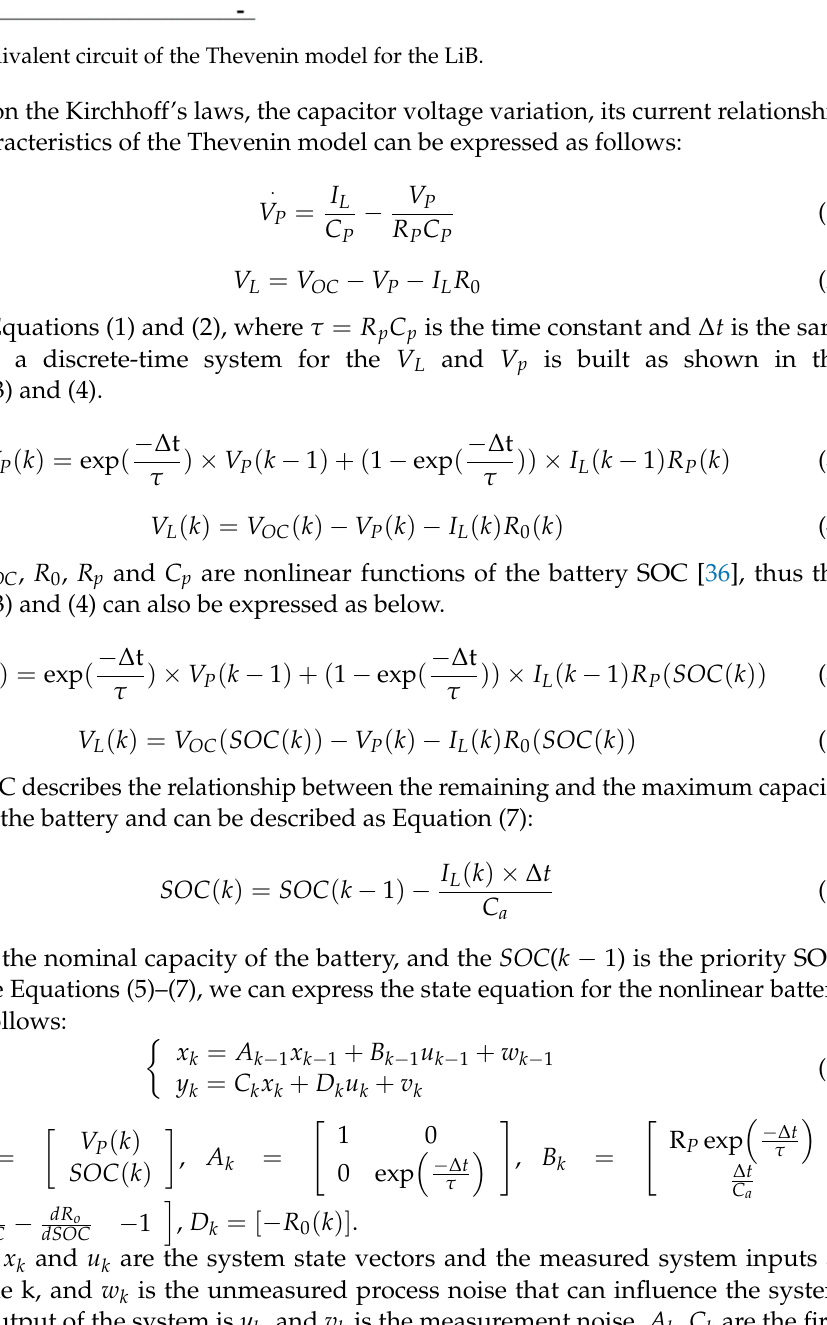
Figure 6. Equivalent circuit of the Thevenin model for the LiB.